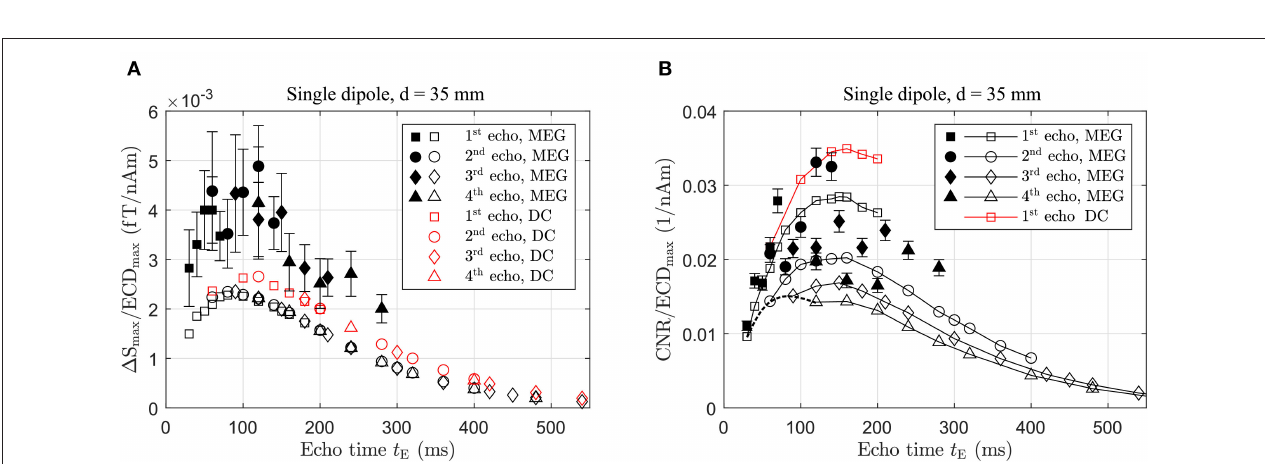
FIGURE 9 | (A) Dependency of 1 S max /ECD max and (B) CNR/ECD max for varying echo times t E and a voxel size of 25 mm. Open markers represent noise-free simulations and filled markers phantom experiments using 80 µ A. Results are grouped according to echo number and an example for data belonging to t Ph = 15 ms are connected by the dashed black line in (B)